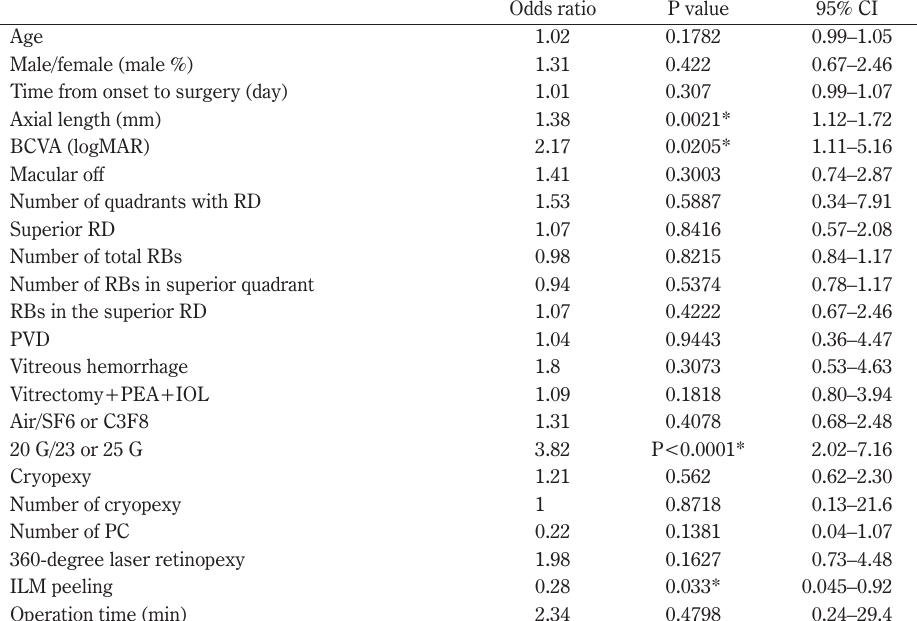
Table 2 Risk factors (odds ratio and 95% CI) for ERM surgery after RRD repair (odds ratios after adjusting for age, sex and 95%